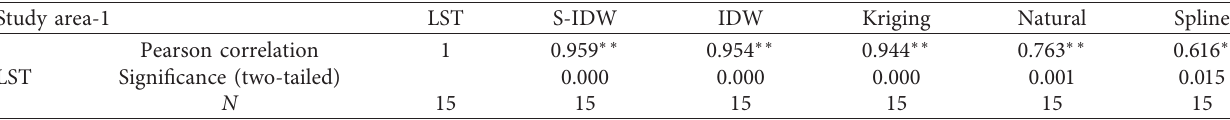
Table 5: Correlation analysis of interpolation results of 5 kinds of interpolation methods on Jan. 11, 2018.